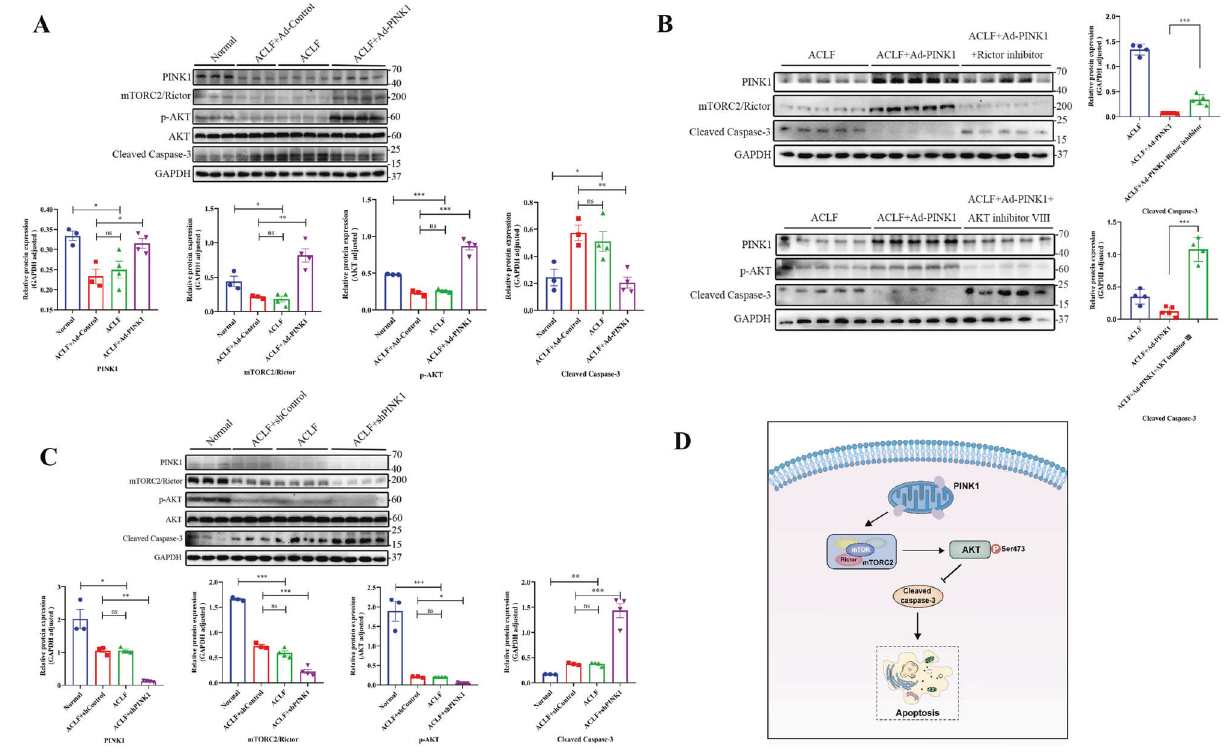
Fig. 7 Study of apoptosis after overexpression and/or knockdown of related factors in animal models. A Overexpression of PINK1 in the ACLF mouse model, and detection of changes in apoptotic proteins. B Based on PINK1 overexpression, Rictor and AKT inhibitors were supplemented, respectively, and cleaved caspase-3 changes were assessed. C Further knockdown of PINK1 in the ACLF model was performed to observe the alteration of the apoptosis-related protein cleaved caspase-3 by WB; Image J was used for analysis. D The theoretical model demonstrating how PINK1 inhibits apoptosis through the activation of the mTORC2/p-AKT pathway. * P < 0.05; ** P < 0.01; *** P < 0.001; **** P < 0.0001; ns not signi fi